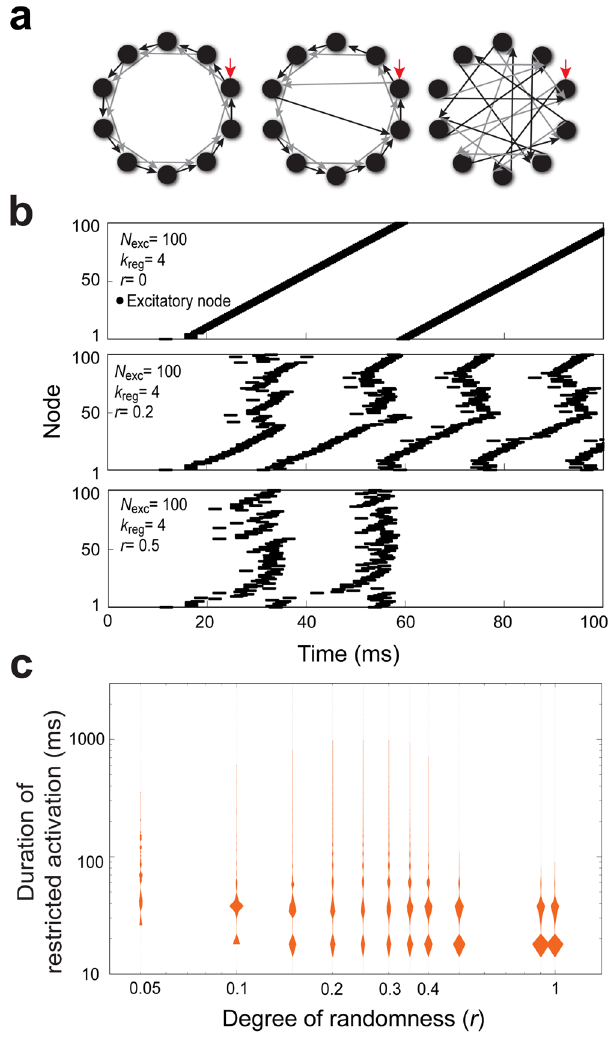
Figure 4. Random rewiring of node connections in a regular network to simulate LN variability. ( a ) Diagram depicting random rewiring of the connections between nodes in the basic regular network. Left : the basic regular network structure, in which the degree of randomness ( r ) is 0. Middle : network structure after one of the two directed edges from two individual nodes was rewired. The larger the degree of randomness, the more frequently directed edges are rewired. Right : when the degree of randomness of the network structure is 1, both directed edges from all individual nodes are rewired. ( b ) The dynamics of network ( N exc = 100, k reg = 4) activation are shown as spike raster plots. Top : When r = 0, the networks show ceaseless and regular activation patterns. Middle : When r = 0.2, some simulated networks showed irregular restricted activation patterns (example trace, 458.85 ms). Bottom : With a higher degree of randomness, r = 0.5, some simulated networks showed irregular and restricted activation patterns, with short duration of activation (example trace, 58.8 ms). ( c ) Five thousand network structures were simulated by randomly rewiring the directed edges from nodes in the basic regular network ( N exc = 100, k reg = 4) at a given r . When r = 0, none of the simulated network structures exhibited restricted activation, and therefore, these data are not shown on the plot. The duration of restricted activation (orange, ∈ [15,1000]) is shown as violin plots. A statistically significant difference among groups was found by the Kruskal-Wallis H -test ( p < 0.0001) (Table